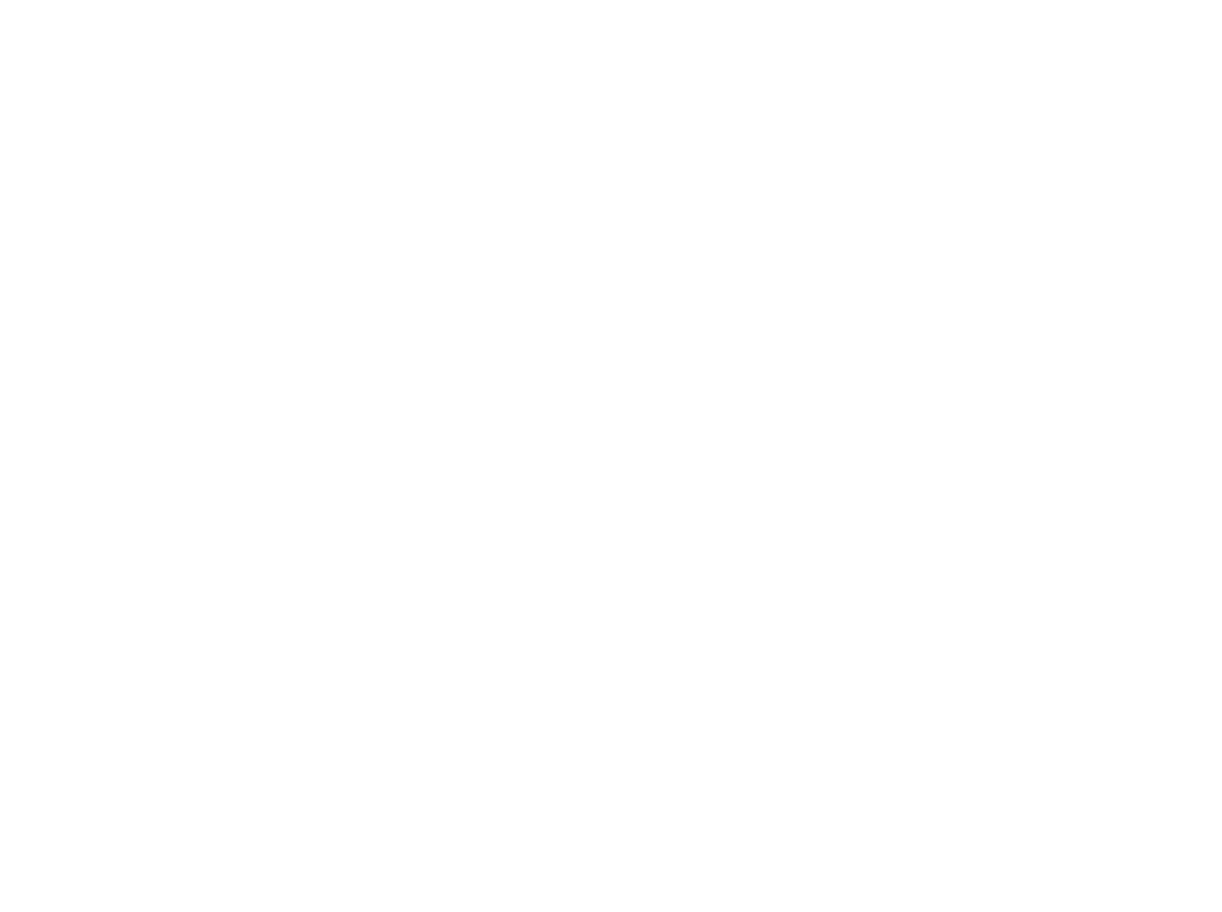
FIGURE A2 | Rostro-caudal extension of the the D2R/ A2aR-expressing MSNs-poor zone of the caudal striatum. (left panel) GFP immunofluorescence in a parahorizontal section of Drd2-Cre crossed with the reporter line RCE:LoxP . Scale bar, 200 μ m. (right panels) Frontal view of the striatum corresponding